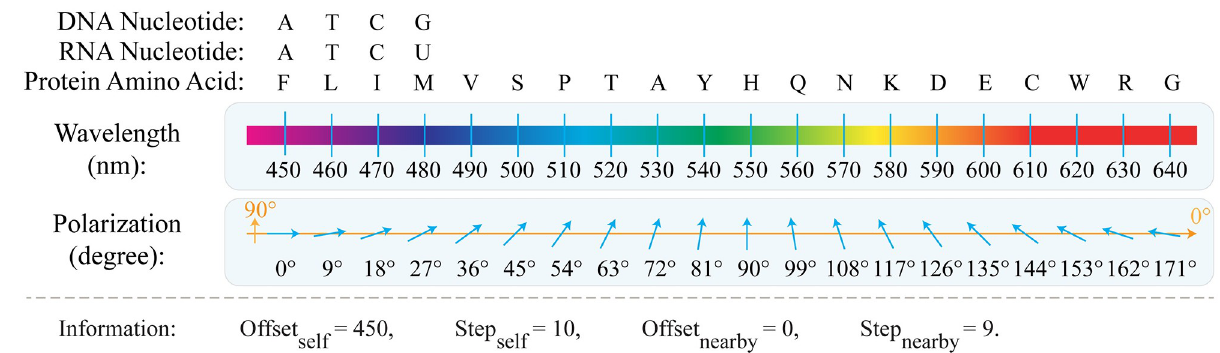
Fig 7. Modulation approach of the HELIOS Optical architecture, utilizing the wavelength and polarization of the optical beams. To implement the self-label coding through the wavelength modulation approach, every character of the input sequence is modulated with a distinct wavelength, within the spectral range of [450–650] nanometers with bandwidth of 10 nanometers. On the other hand, to implement the nearby-label coding through the polarization selection approach, every character of the input sequence is assigned to a specific polarization along a 9-degree azimuth angle in the range of 0 to 180 degrees. Each approach provides twenty distinct codes for protein sequences, while only four of them are employed for coding DNA and RNA sequences.